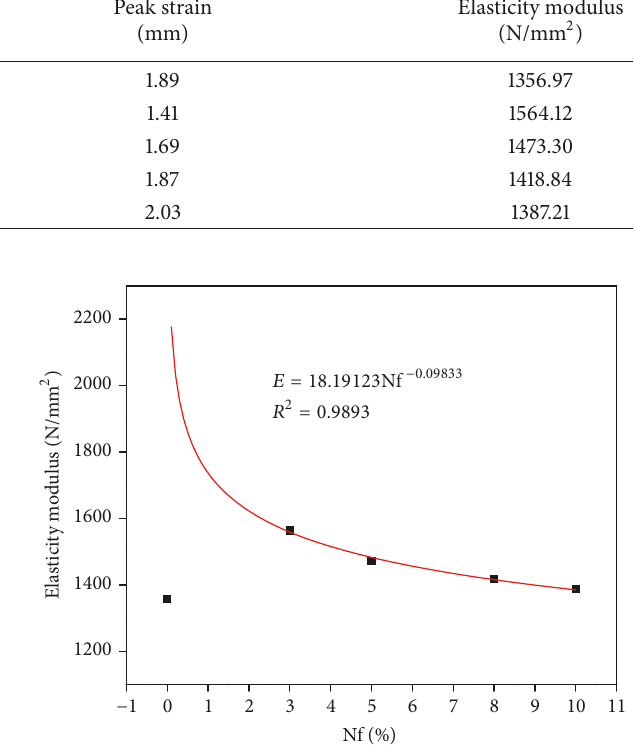
Figure 7: Plot of elasticity modulus against CaCO 3 whisker.